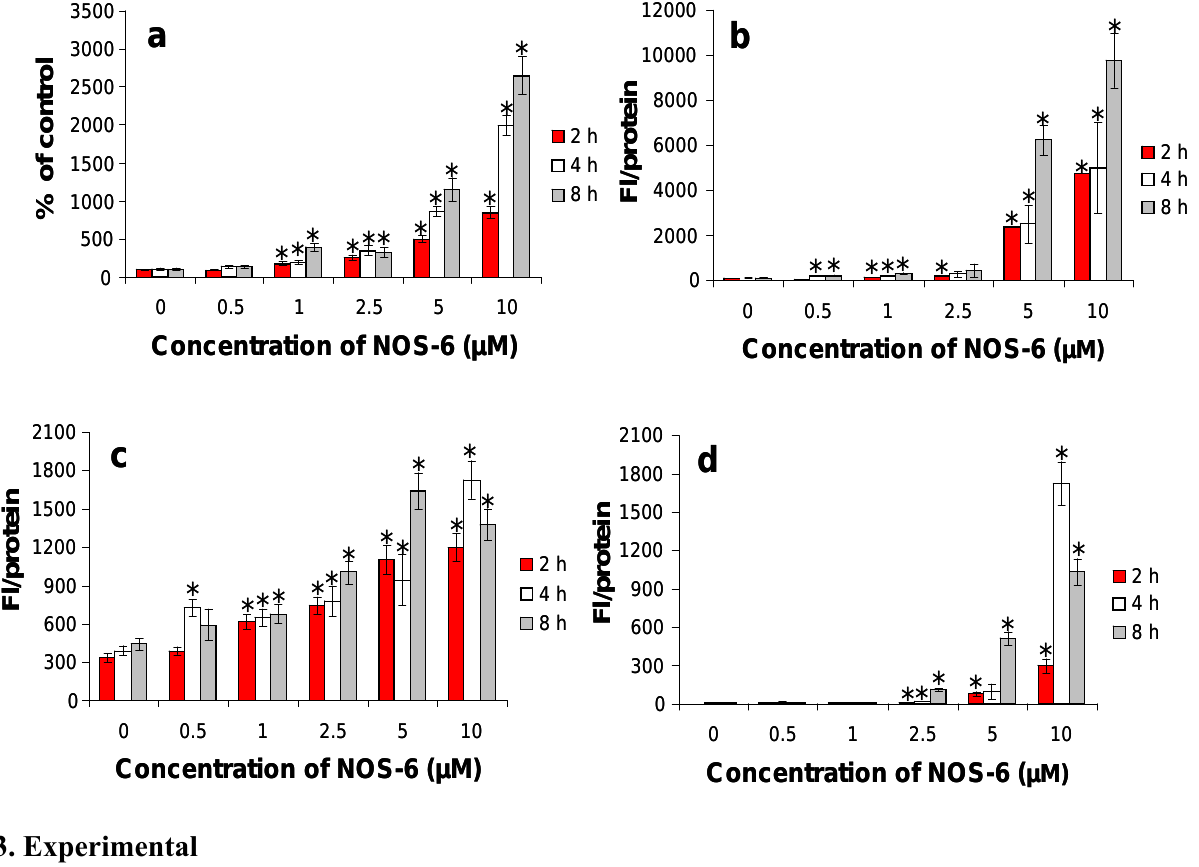
Figure 4. Effects of NOS-6 on (a) the cellular membrane integrity measured as LDH in medium and (b) caspase 3, (c) caspase 8 and (d) caspase 9 activities in mouse fibroblasts (BALB/c cells). Fibroblasts were treated with NOS-6 (1–10 μ M) for 2/4/8 h; control cells were incubated with DMSO (0.5%; v/v) under the same conditions. Data are presented as means ± S.D. of three independent experiments. FI/protein = Relative Fluorescence Intesity per mg of soluble proteins. (*) p < 0.05 statistically different from the untreated cells. b